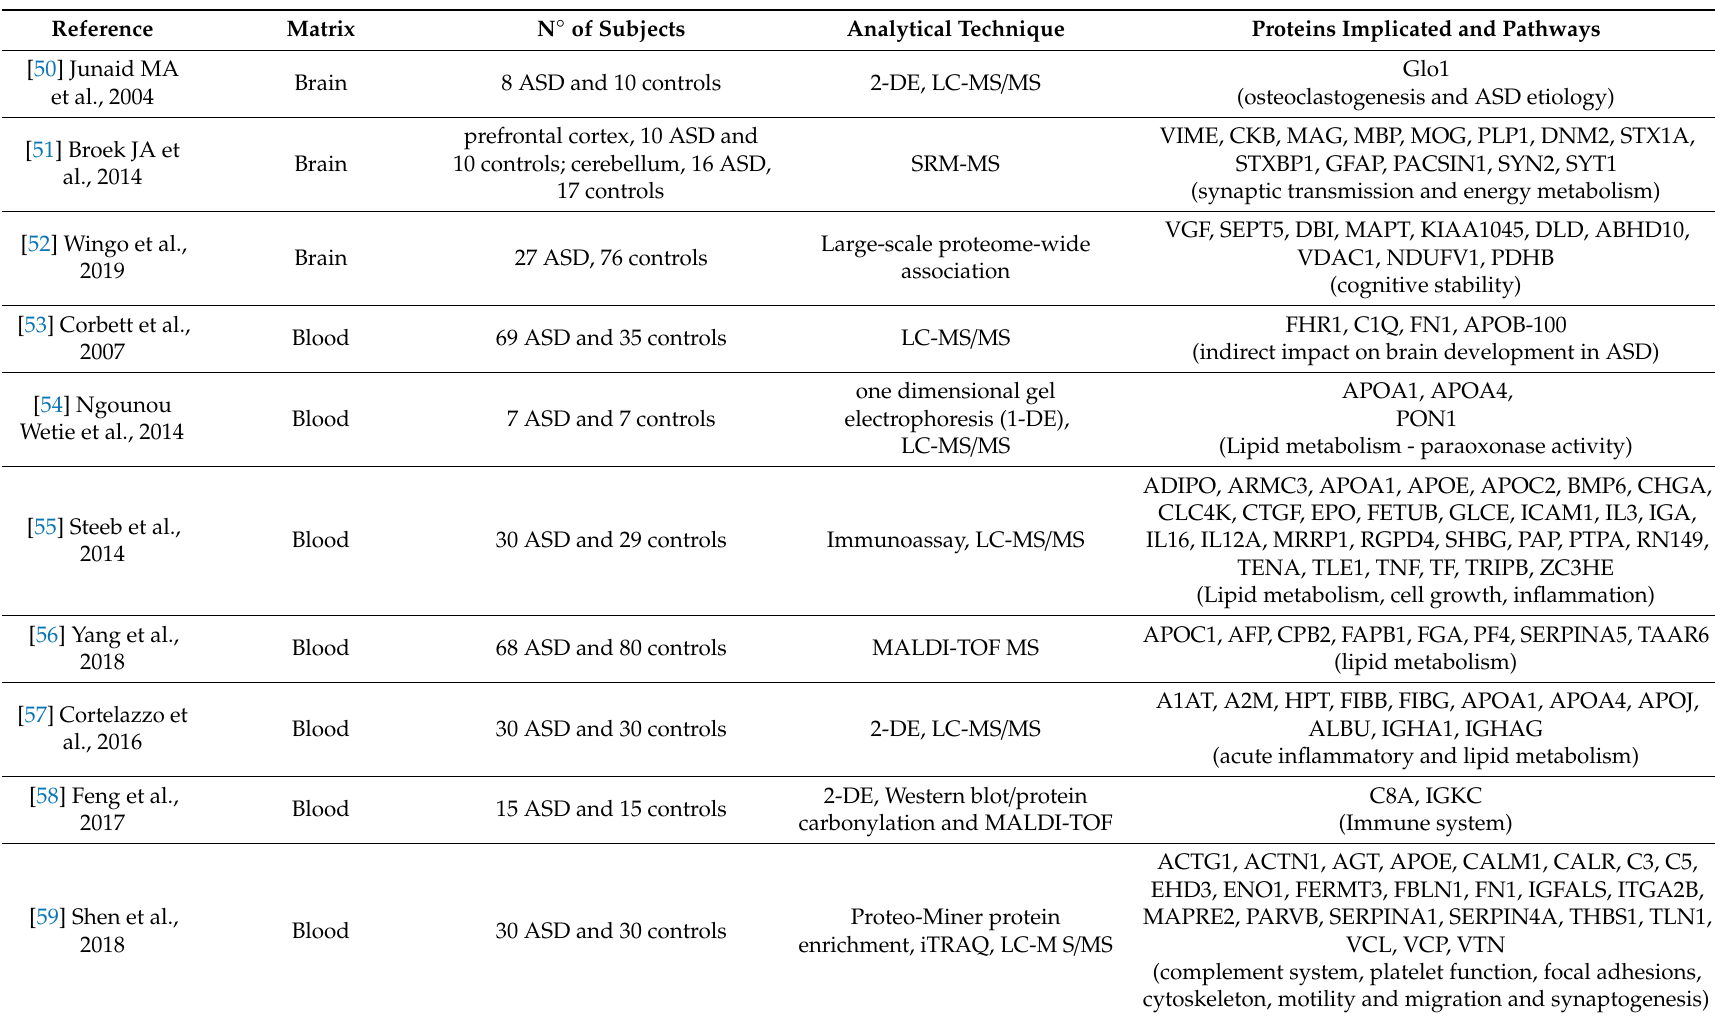
Table 1. Proteomics-based targets of